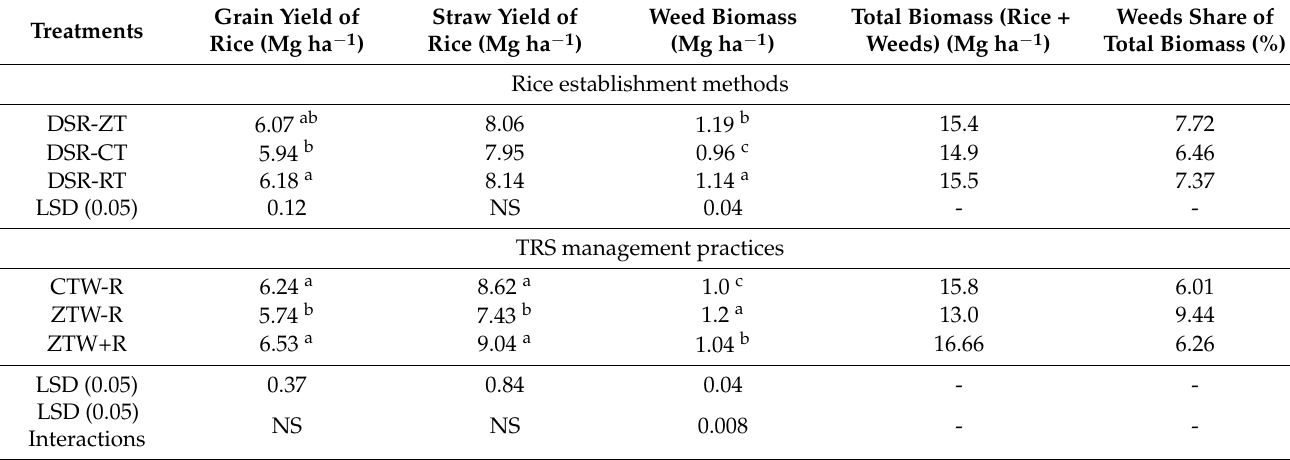
Table 2. Yield of the rice grain, straw and weed biomass under different rice establishment methods.